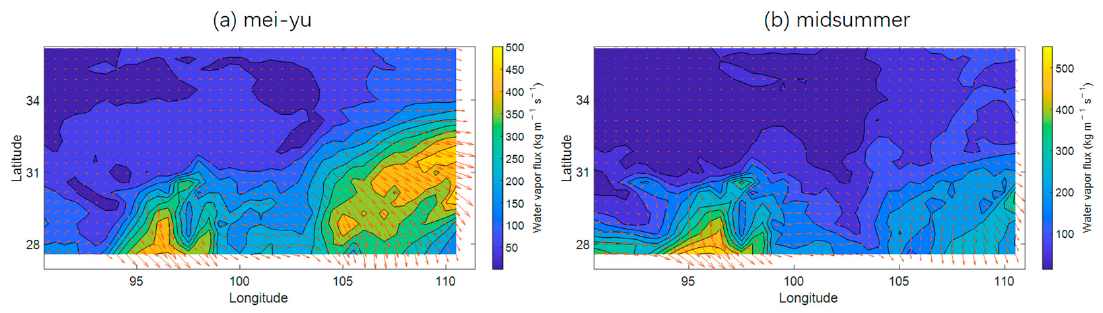
Figure 9. Correlation between ( a ) dewpoint spread and CBH and ( b ) water vapor flux and ∆V dur- ing the mei-yu (blue line) and midsummer (red line) periods. ( c , d ) Correlation of ∆V , CAPE, cloud LWC and IWC with precipitation rate during the ( c ) mei-yu and ( d ) midsummer periods.